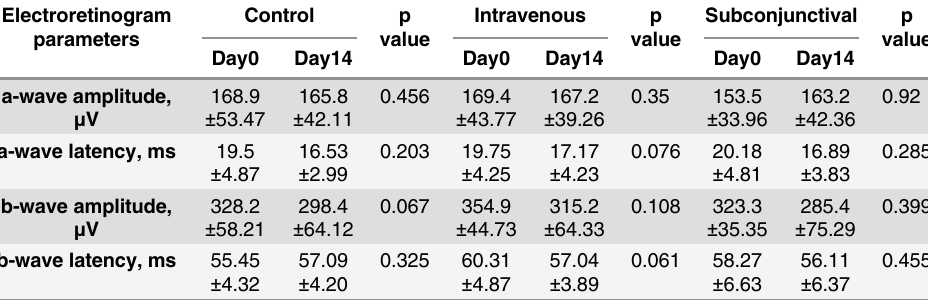
Table 2. Analysis of retinal function by electroretinography